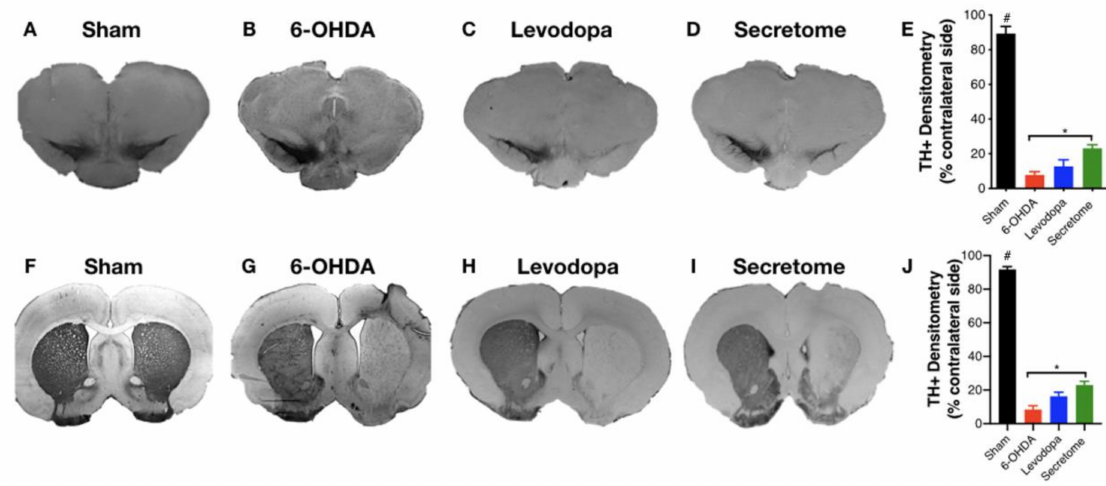
Figure 4. Striatum (STR) and Substantia nigra (SN) brain slices photomicrographs stained for Tyrosine Hydroxylase (TH). Compared to the ( A , F ) Sham group, all the animals injected with 6-OHDA had a significant reduction on the TH-positive staining both in the SN and STR. Notwithstanding, animals treated with the ( D , I ) hBM-MSC secretome display a significant impact on STR and SN histological deficit, with more TH-positive cells and fibers being observed when compared to ( B , G ) untreated group 6-OHDA ( E , J ). Concerning levodopa ( C , H ), although a slight increase was observed, no di ff erences were observed when compared to the untreated group 6-OHDA ( B , G ) and hBM-MSCs secretome ( D , I ) both in the SN and STR ( E , J ), respectively. Data presented as mean ± S.E.M. Sham n = 9, 6-OHDA n =